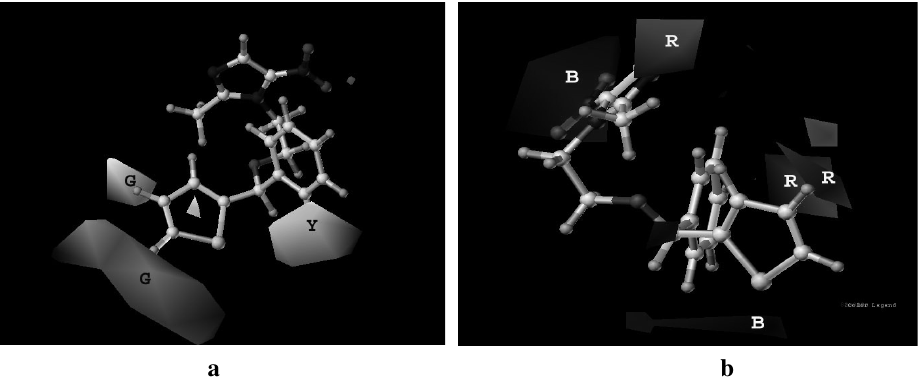
Figure 6. The CoMFA steric and (b) electrostatic contour maps. One of the most active molecules 15 is shown in the background. Red (R) colour is a negative charged region, blue (B) a positively charged region,green (G) a positive sterically active region, and yellow (G) a negatively sterically active region.